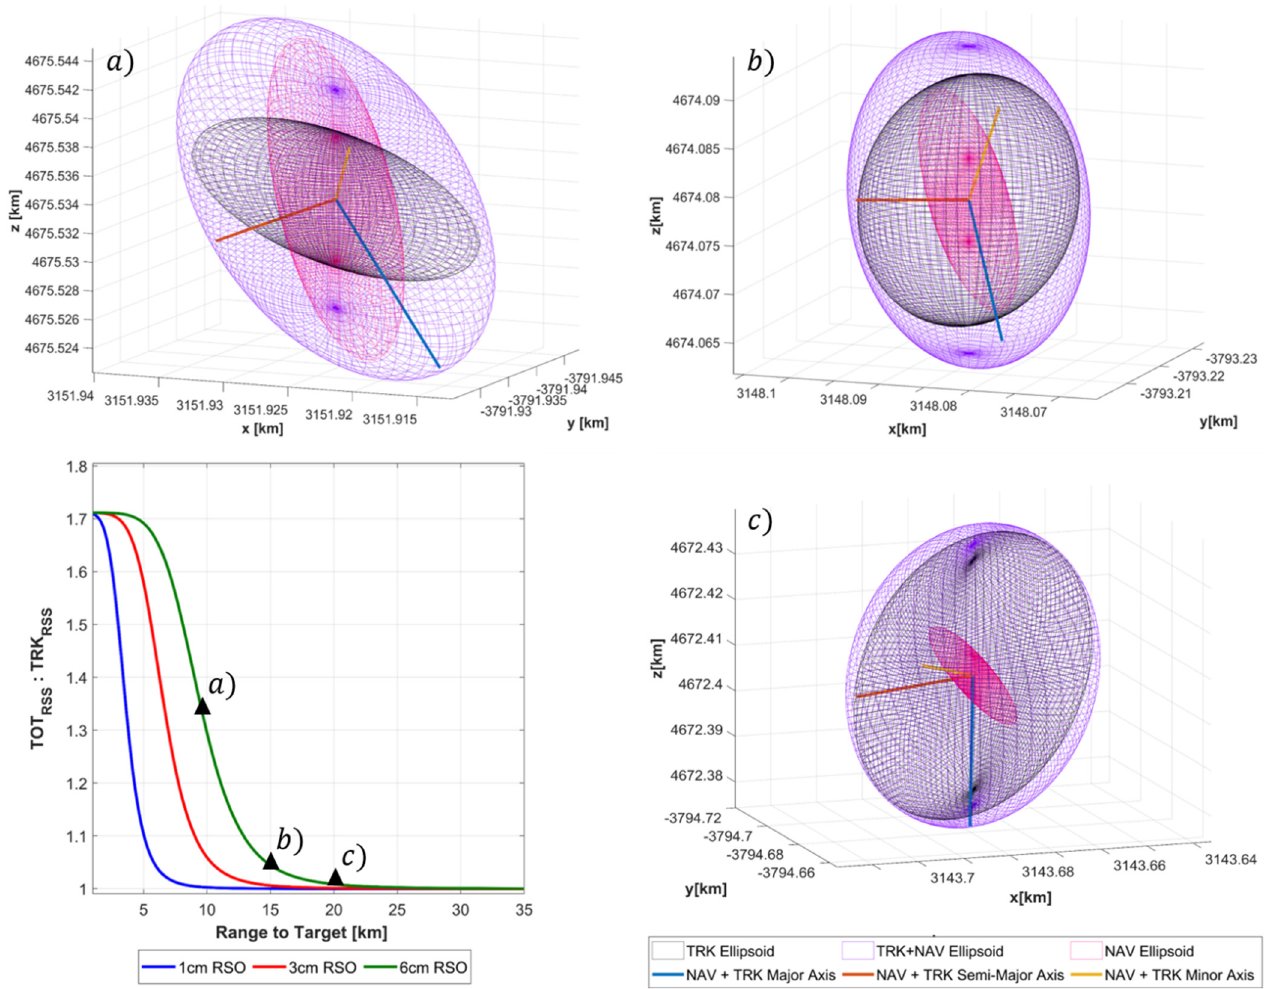
Figure 12: Effect of Navigation errors on total RSO uncertainty of tracked debris (clockwise from top right:). ( a )10 km ( b )15 km, ( c )20 km range to target. In each figure the magenta, black and purple ellipsoids represent the Navigation, Tracking, and Total (NAV+TRK) uncertainty volumes respectively.